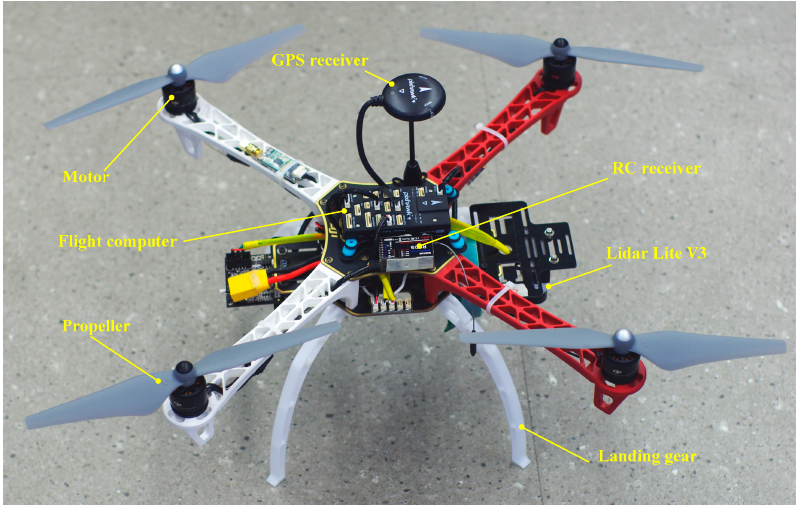
Figure 5. Quadcopter platform used for the experimental demonstration. Table 1. System parameters used for the simulations.